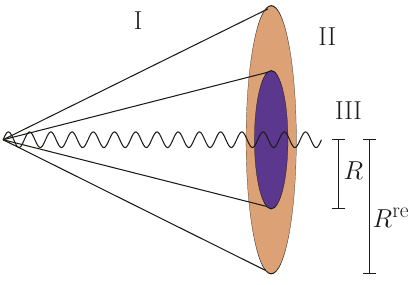
Figure 13 . Isolation cones of radius R and R ref and associated angular regions. The difference ∆ σ is obtained from partonic configurations which fulfill the isolation criterion for cone radius R , but fail it for R ref